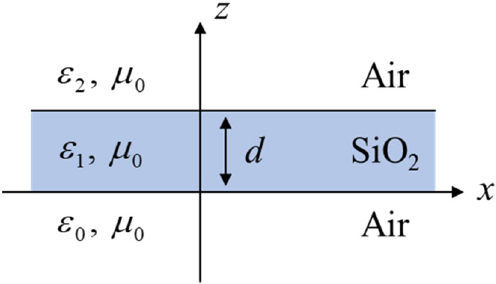
Figure 2. Cross-section of an amorphous SiO 2 thin film surrounded by air.